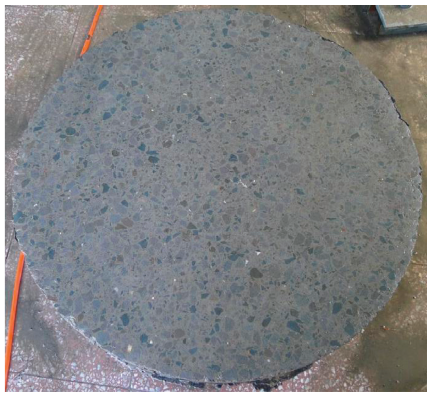
Figure 4: Specimen of the large-scale model of pavement structure.